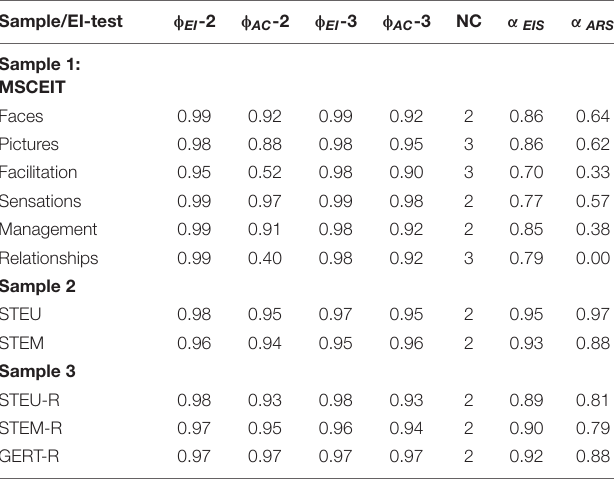
TABLE 1 | Congruence measures (Tucker’s Phi’s) with a priori EI and acquiescent responding component loadings after orthogonal Procrustes rotation, number of selected components, and internal consistencies (Cronbach’s Alpha’s) of component